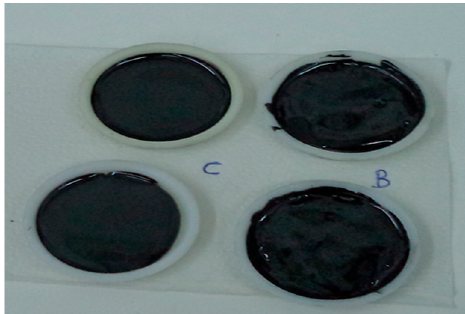
Figure 4. Photos of the epoxy resin filled samples (C: with graphite powder; B: with MWCNT).